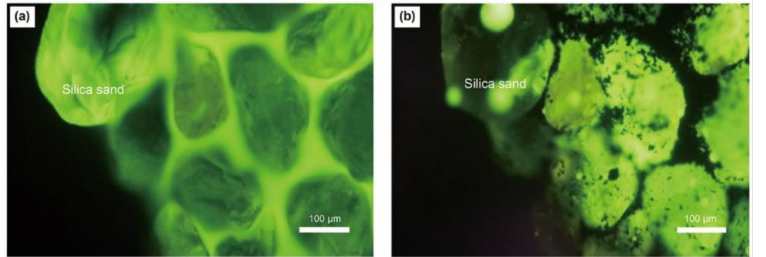
Figure 6. The images of micromodel ( a ) before and ( b ) after the injection of 2 wt% nickel nano-catalyst suspension in the presence of 0.5 wt% sodium laurilsulfate (SDS) and 0.06 wt%